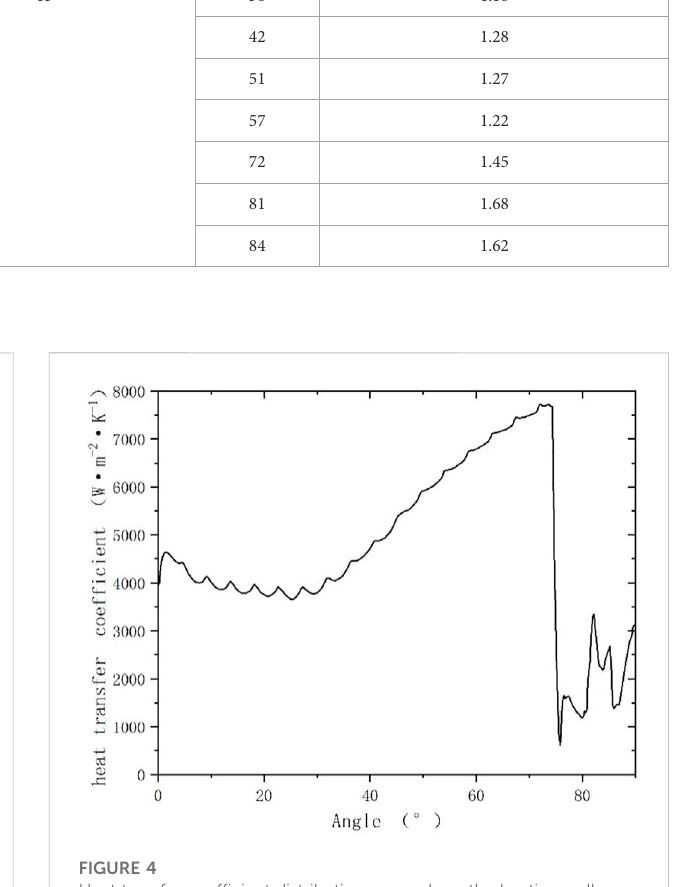
Heat transfer coef fi cient distribution curve along the heating wall.